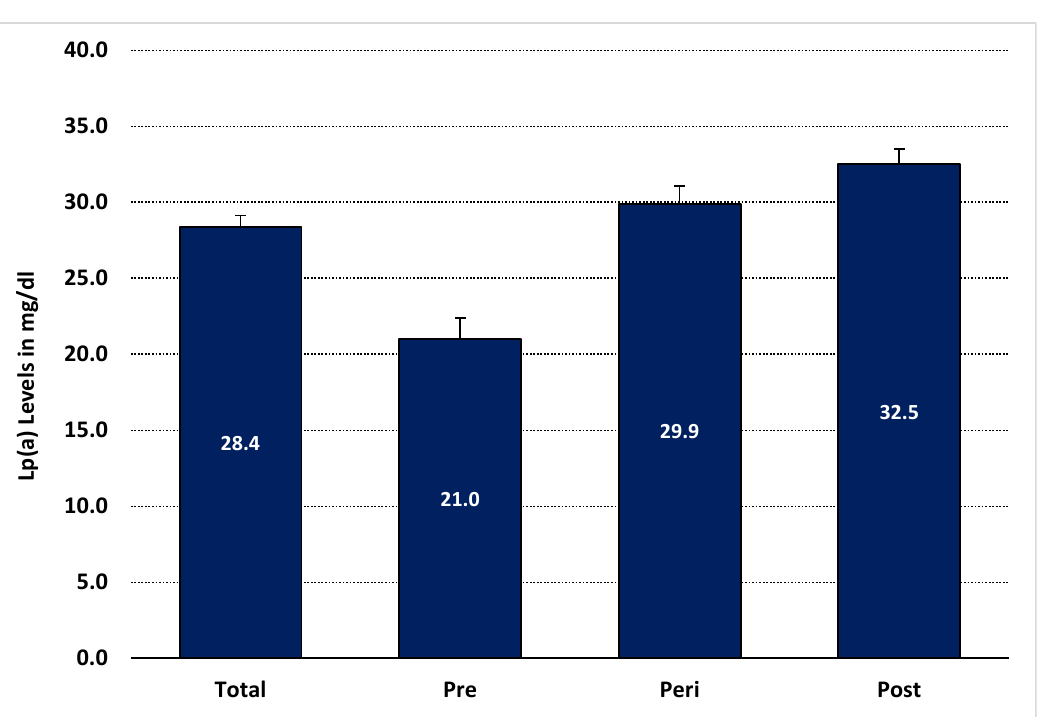
Figure 1. Comparing lipoprotein(a) level in premenopausal, perimenopausal, and postmenopausal women. Note: Data are presented as the mean of lipoprotein(a) level in mg/dL in each group according to menopausal status. Abbreviations: Lp(a): lipoprotein(a); Total: Total sample; Pre: pre- menopausal women; Peri: perimenopausal women; Post: postmenopausal women.